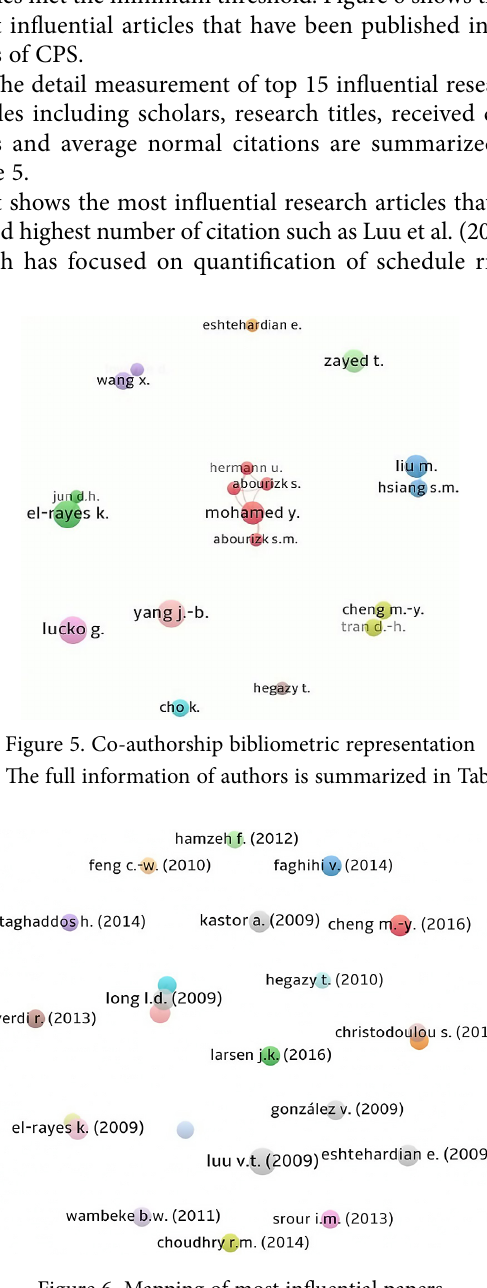
Figure 6. Mapping of most influential